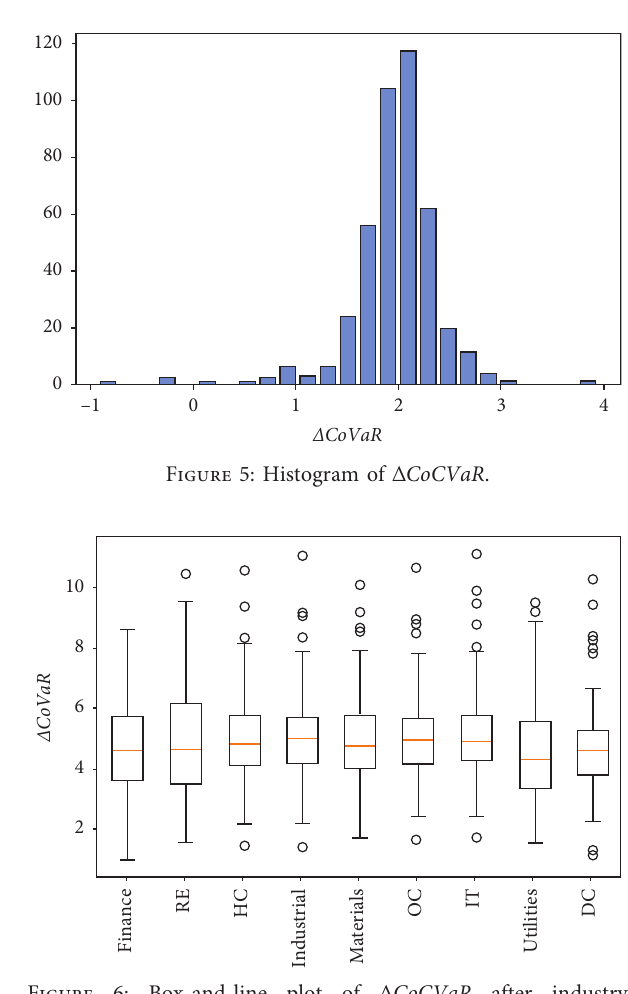
Figure 6: Box-and-line plot of ∆ CoCVaR after industry